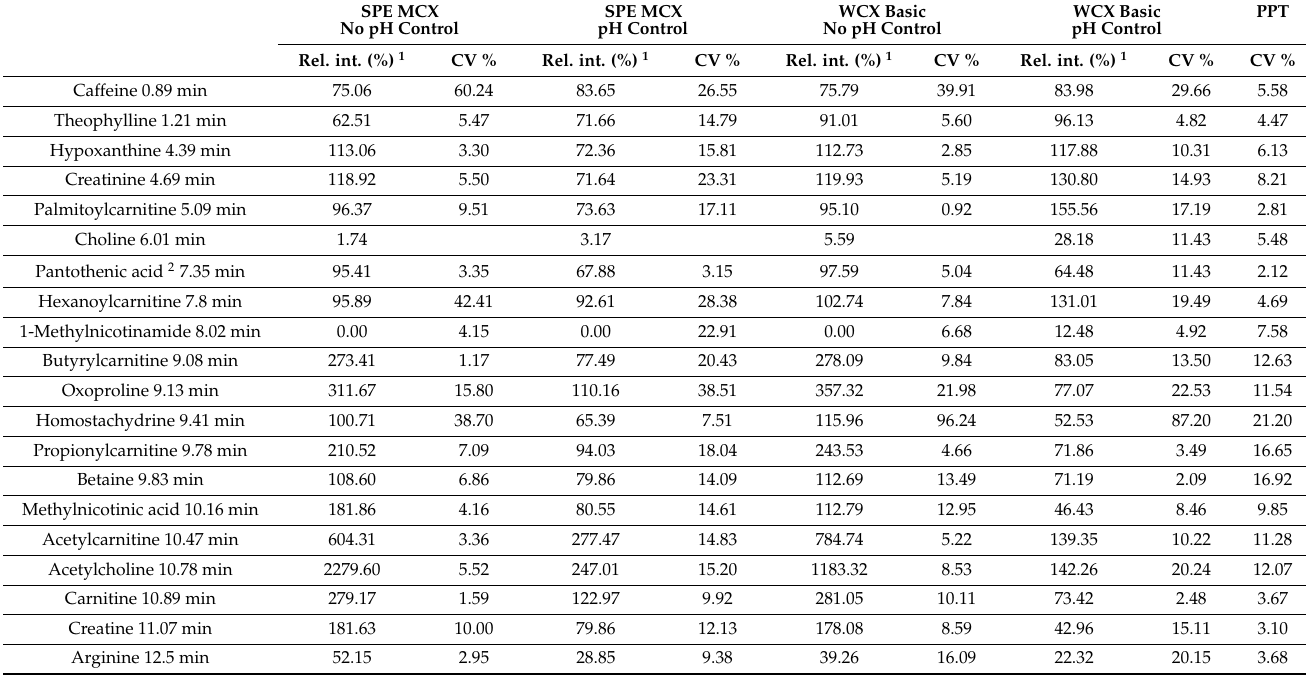
Table A2. Summary of relative peak area 1 and CV (%) of the investigated analytes in the experiment where pH buffering in all steps of the SPE protocol was tested. 1 mean of SPE replicates/mean of PPT replicates expressed as percent (%). 2 The analyte was detected as a